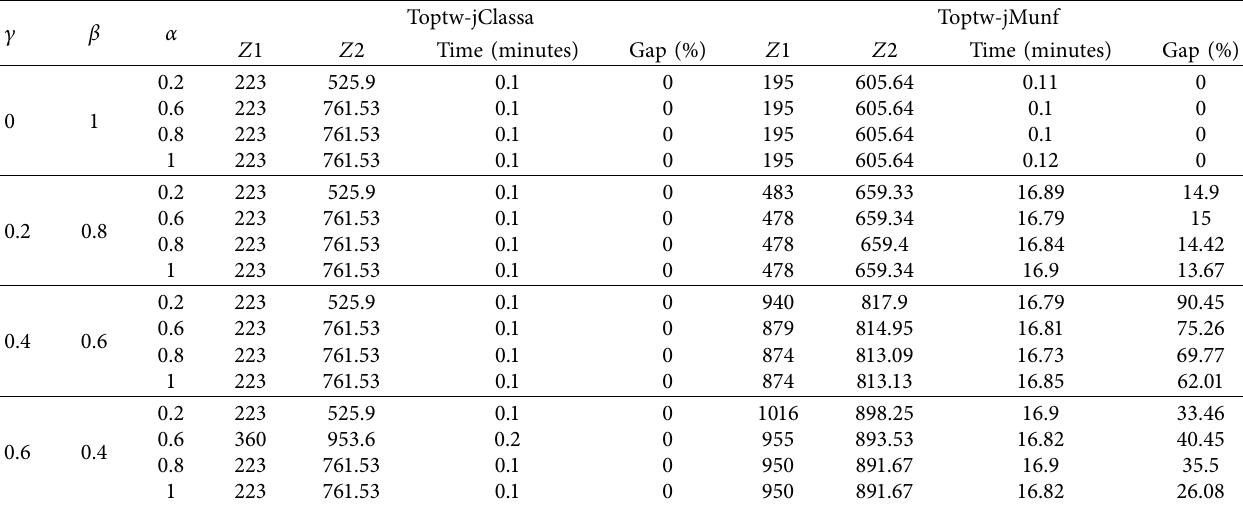
Table 4: Numerical results for real instances Toptw-jClassa and